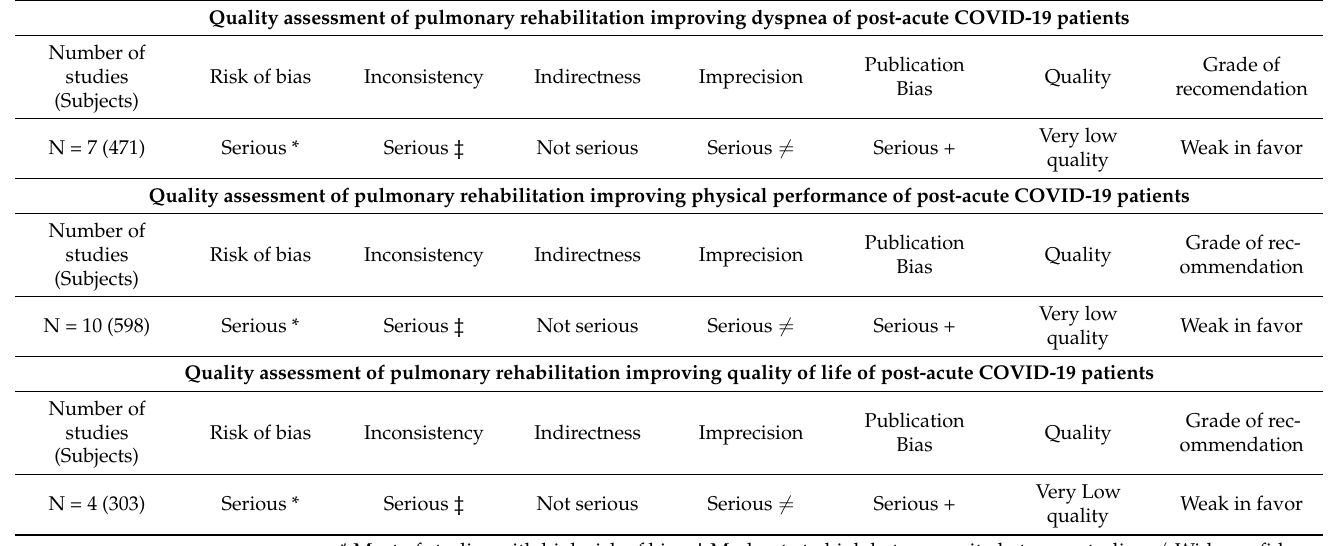
Table 4. Summary of findings for included studies using the GRADE quality of evidence